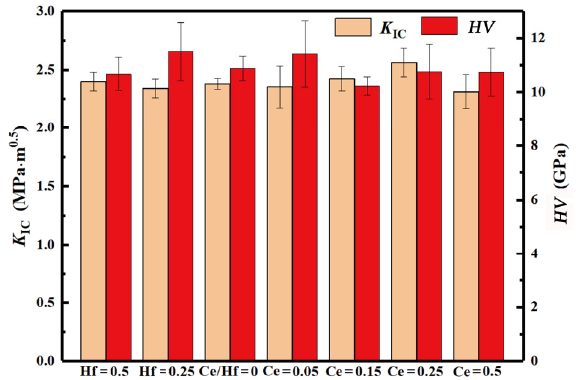
Fig. 5 HV and K IC of A 2 B 2 O 7 high-entropy